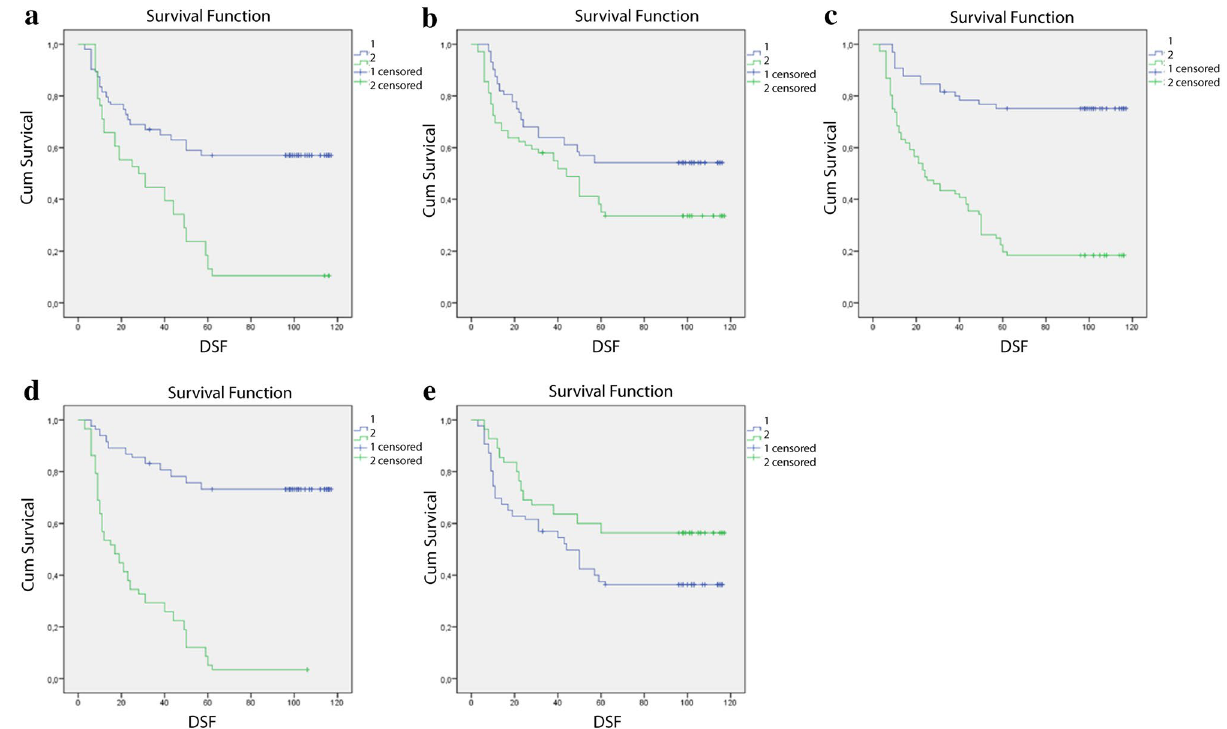
Figure 2. Kaplan–Meier disease free interval (DFS) curves relative to different indicators. ( a ) degree of differentiation: well differentiated carcinomas (blue line); poorly differentiated carcinomas (green line). ( b ) age groups: ≤ 62 (blue line); > 62 (green line). ( c ) expression of IMP 3: IMP 3 negative expression (blue line); IMP 3 positive expression (green line). ( d ) vascular invasion: no vascular invasion (blue line); vascular invasion present (green line). ( e ) gender: female (green line); male (blue